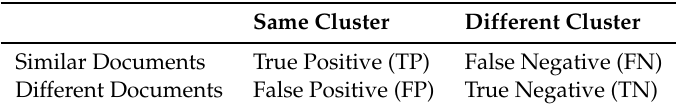
Table 1. Confusion